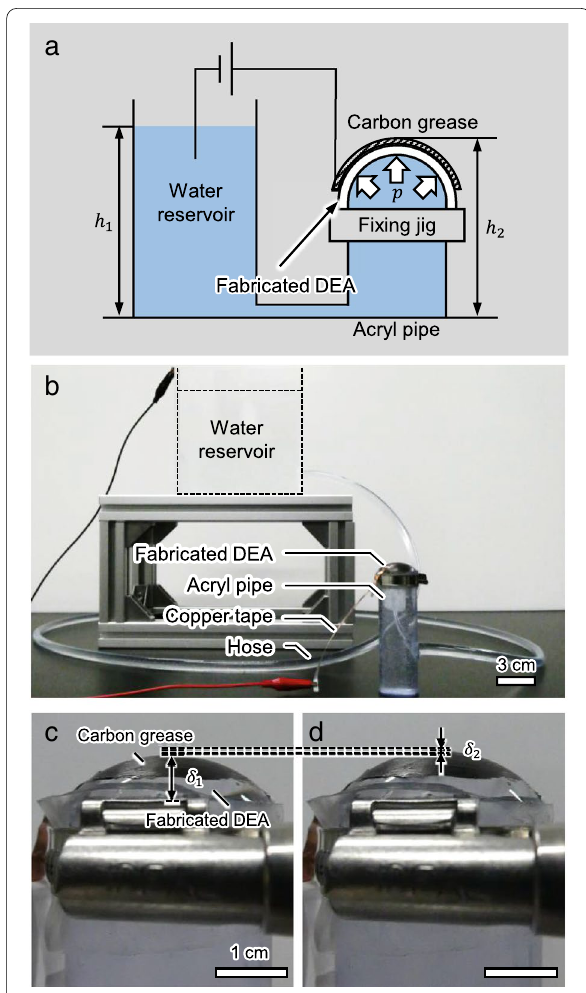
Fig. 3 Experimental system of DEA actuation with water pressure. a Schematic of the experimental system. b Photograph of the experimental system, c DEA without electric voltage, d DEA with electric